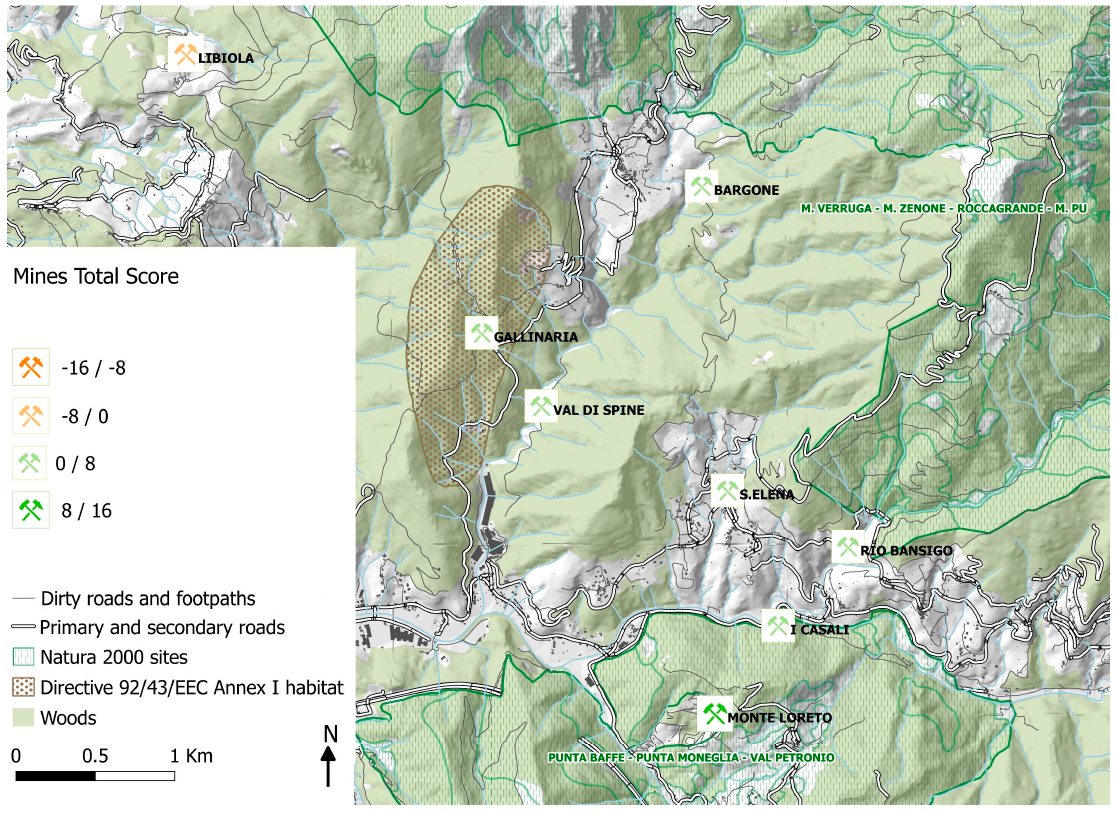
Figure 6. Map with a graphical representation of the total scores of the eight selected sulfide mines.